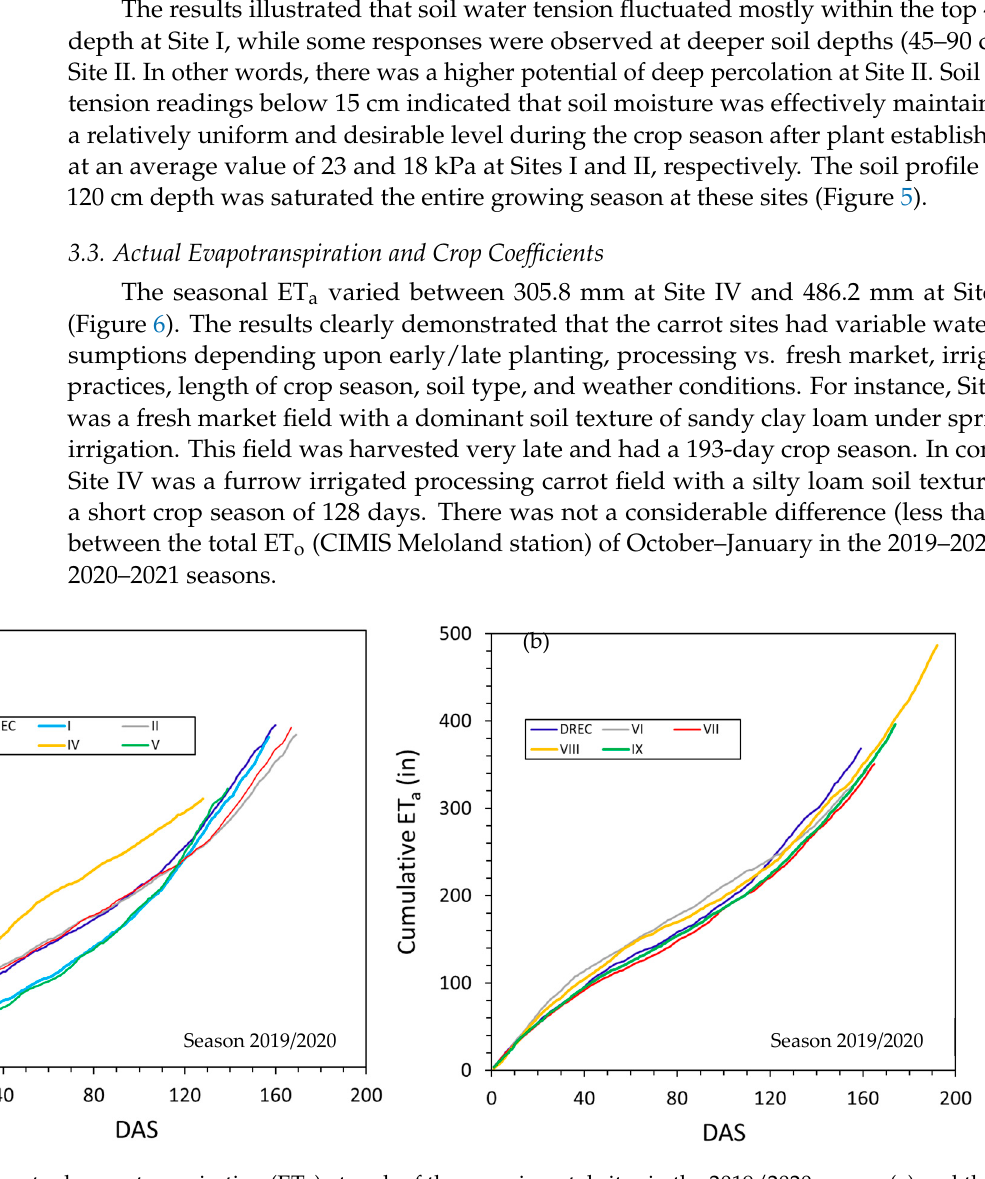
Figure 6. Cumulative actual evapotranspiration (ET a ) at each of the experimental sites in the 2019/2020 season ( a ) and the 2020/2021 season ( b ). Surface renewal daily ET a is reported for the sites.